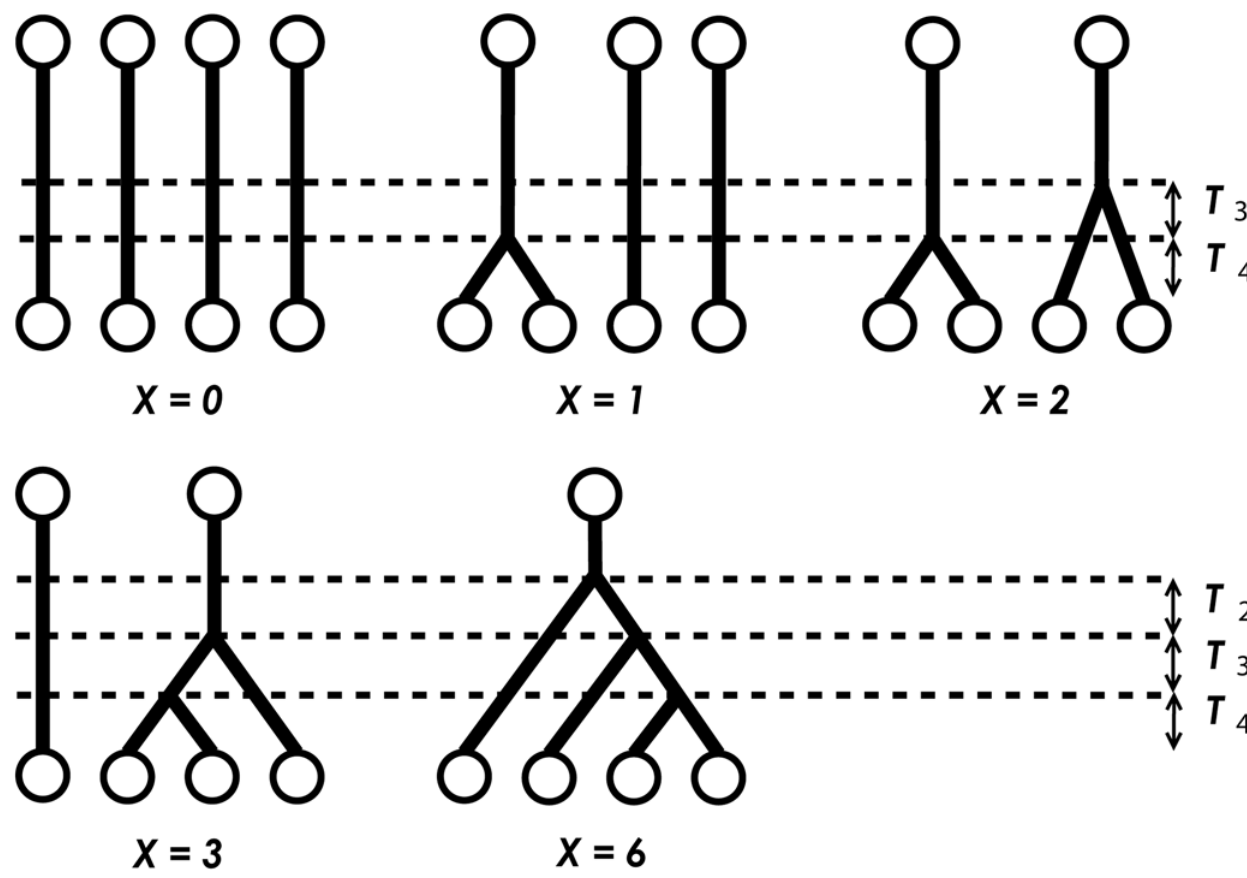
Figure 1. Coalescence events among four alleles randomly sampled from a population. T k , k ~ 1,2,3,4 is the time to the most recent common ancestor of k alleles randomly sampled from a population. X is the number of IBD pairs of alleles when choosing two alleles randomly from the union of four alleles of a marker of a pair of individuals. For simplicity, subscripts i , j are omitted.